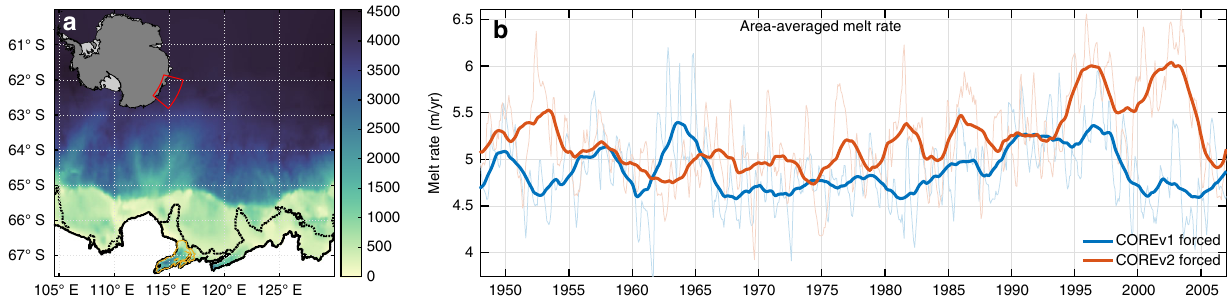
Fig. 1 Modelled TIS basal melting. a Domain and model bathymetry with TIS outlined orange. b Area average melt rate for COREv1 repeated normal-year forcing and COREv2 interannual forcing for 1949 – 2007. Raw data (light coloured lines) is smoothed with a 1.5-yr fi